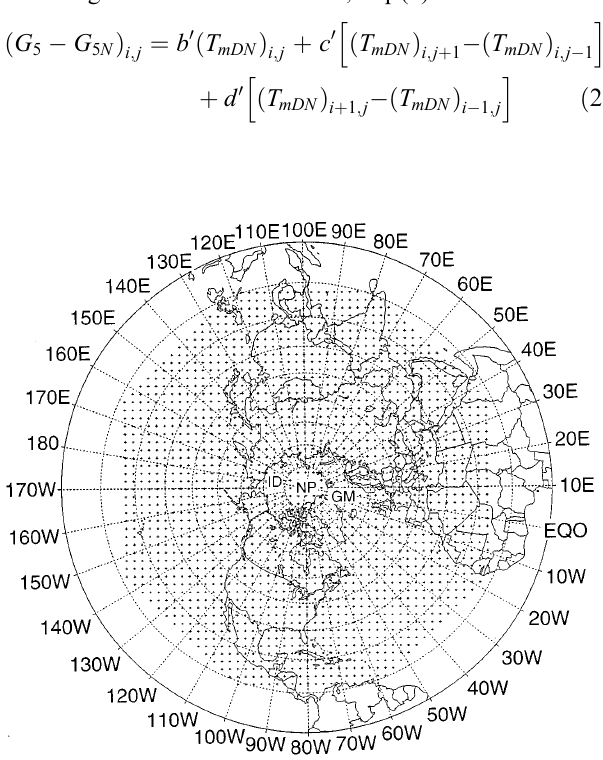
Fig. 1. NMC grid used in the Adem thermodynamic model: 1977 points distributed in a polar stereographic projection where X and Y coordinate axes were arbitrarily determinated along 10 (cid:14) E and 80 (cid:14) W,